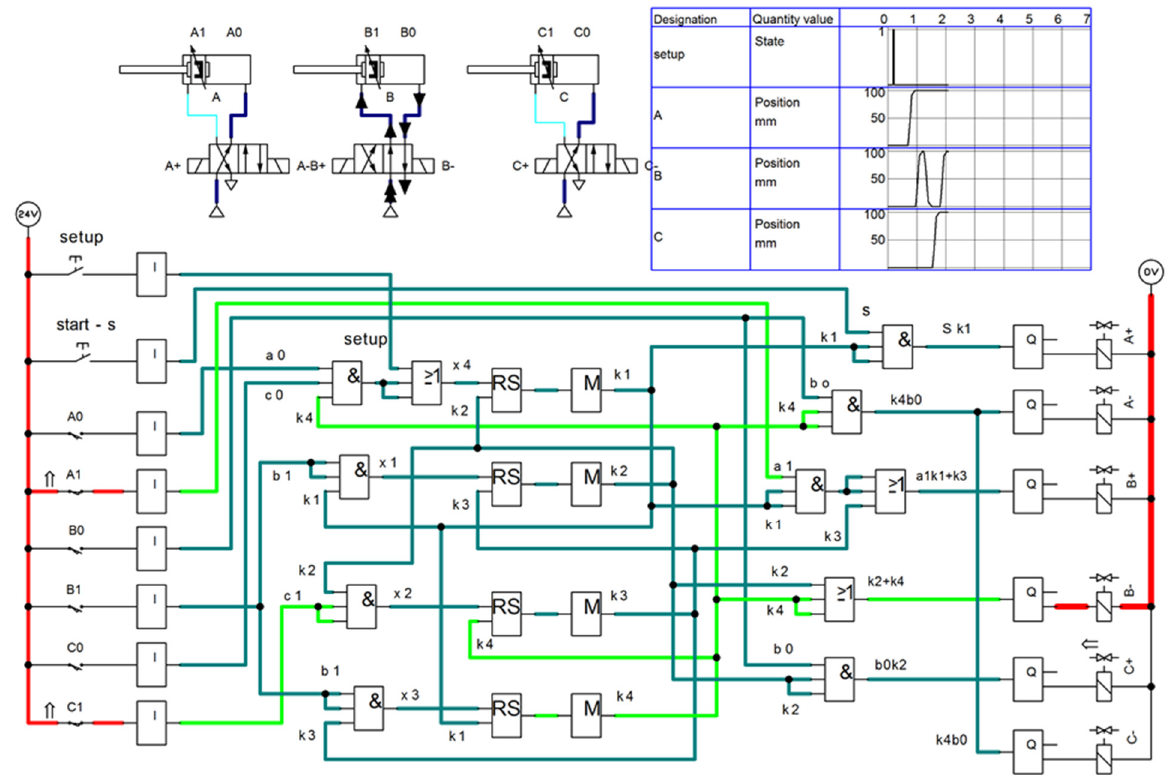
Figure 6. Simulation—system in k4 state, actuator valve B OFF, retraction start of actuator B.